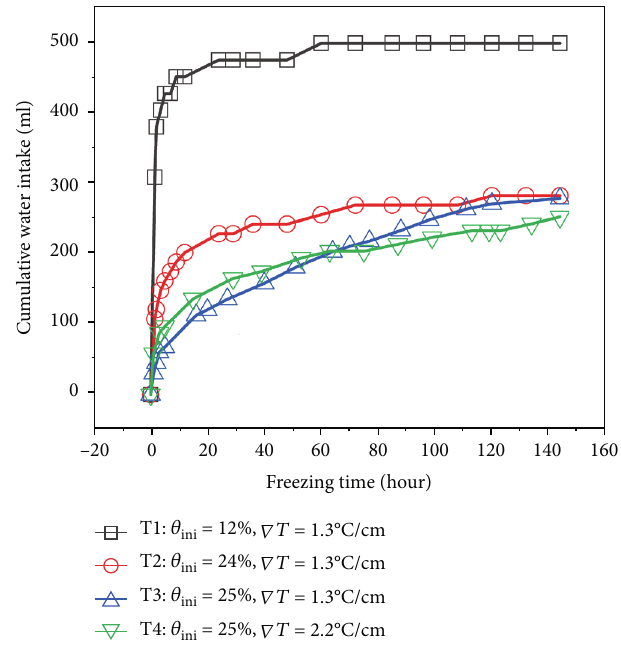
Figure 9: The cumulative water intake changes of the soil